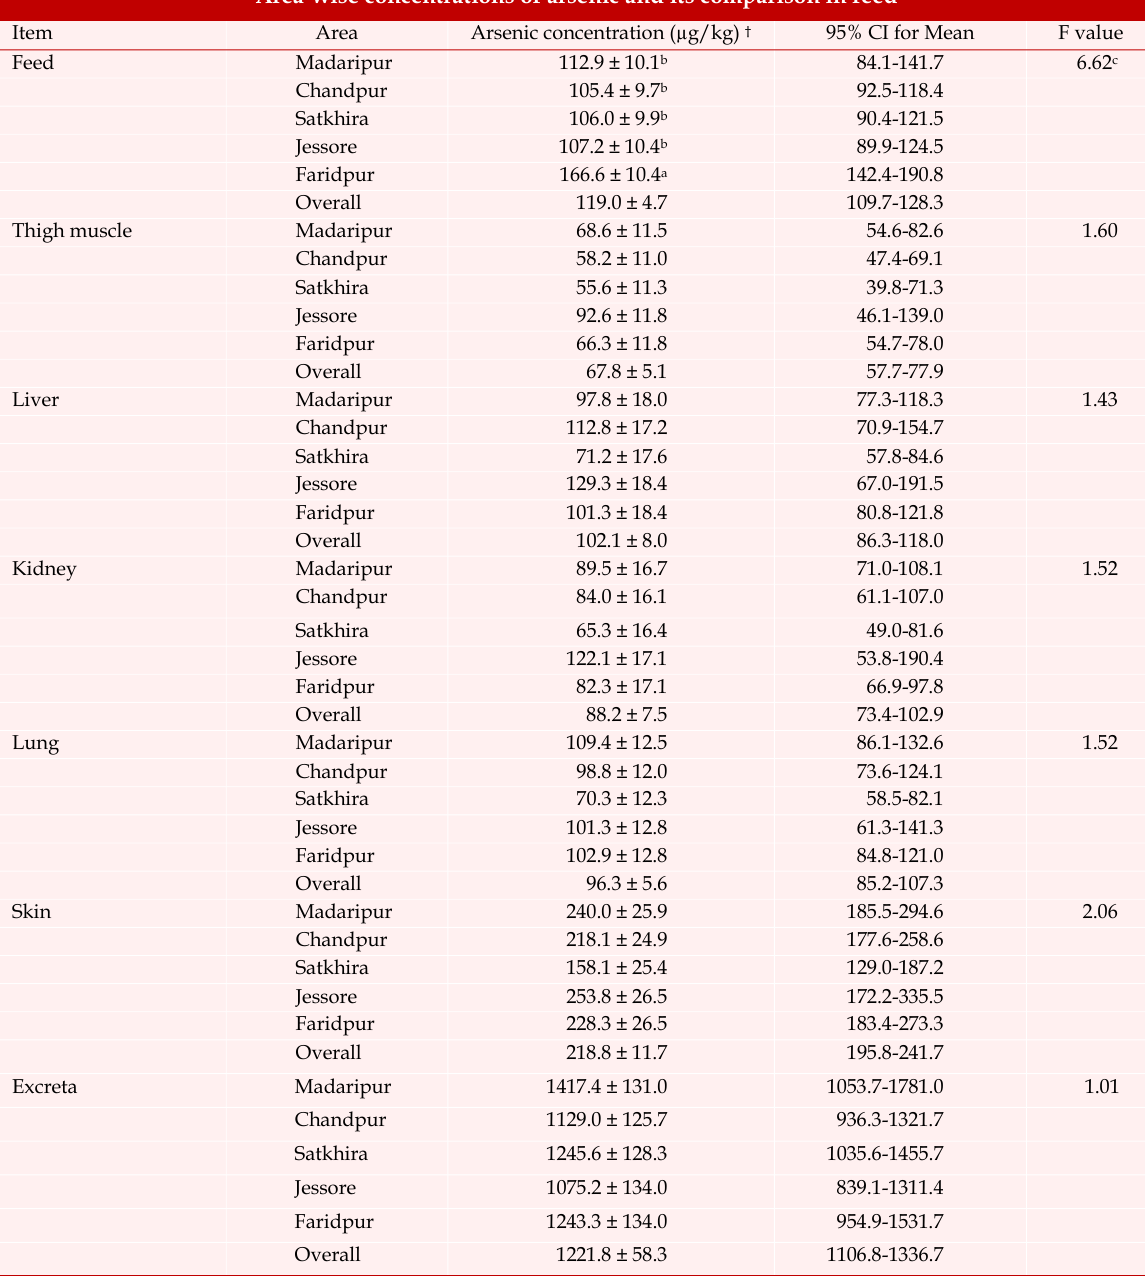
Area-wise concentrations of arsenic and its comparison in